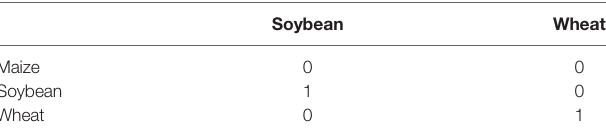
TABLE 1 | Contrast